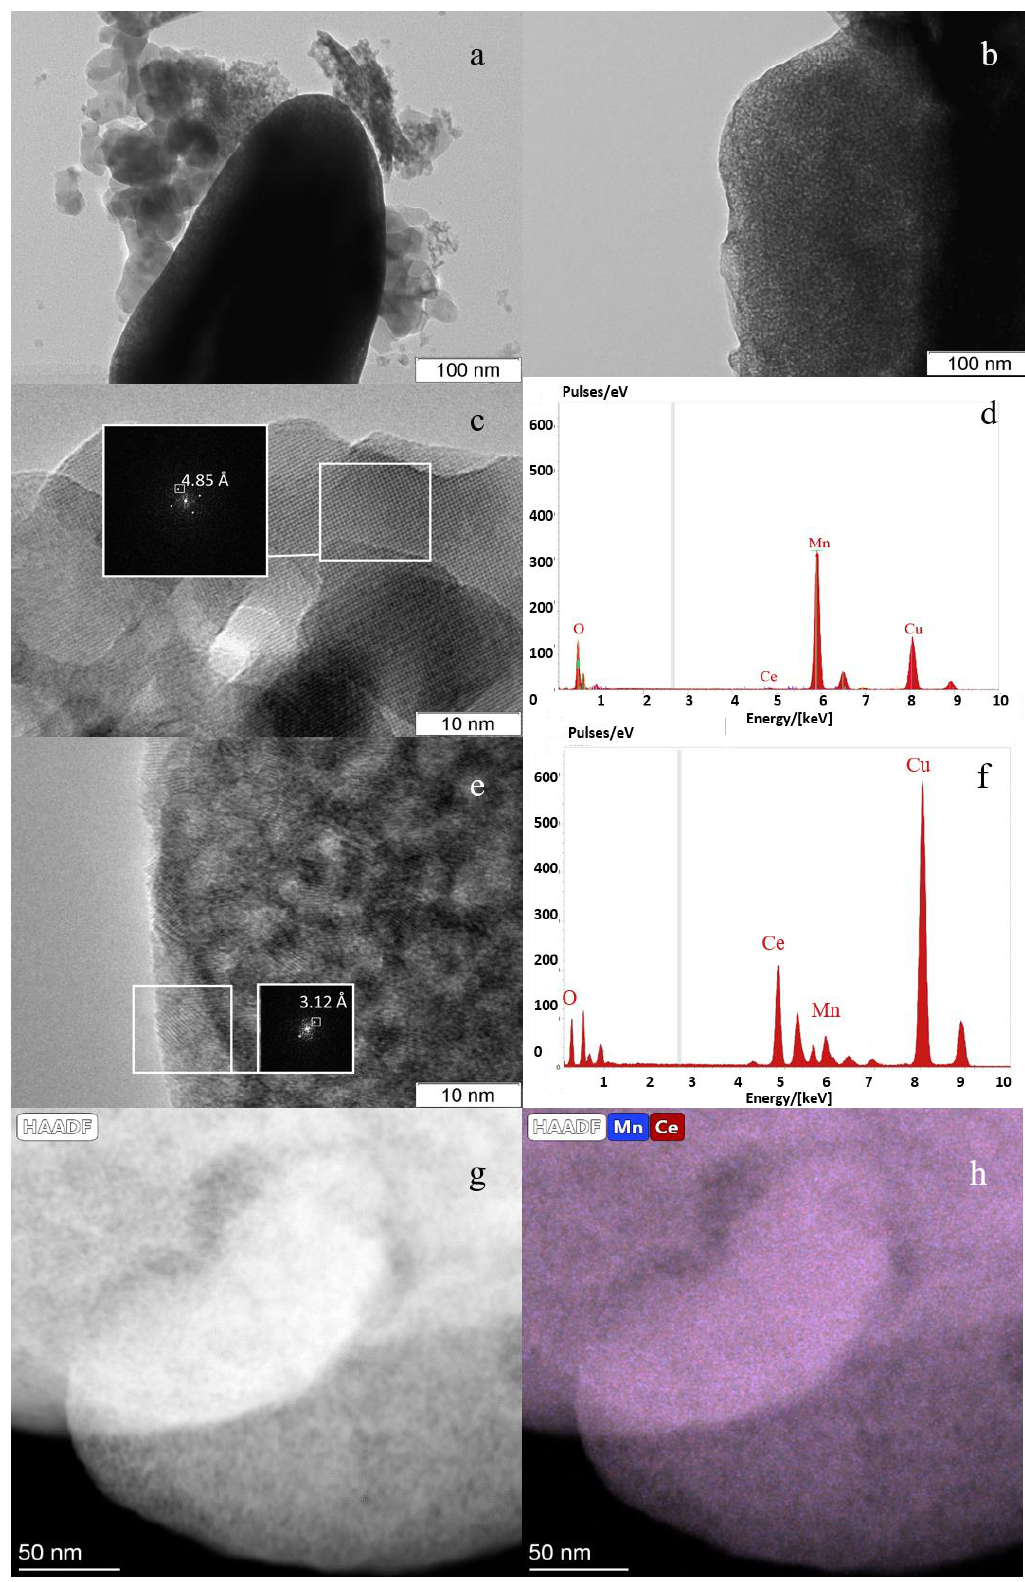
Figure 4. TEM images of Mn0.45Ce0.55 ( a , b , c , e ), EDX spectra of Ce-rich ( f ) and Mn-rich ( e ) regions, EDS mapping ( g , h ). In contrast to XRD and TEM methods, which reveal only structural and microstruc- tural changes, the differential dissolution method is able to determine the cationic